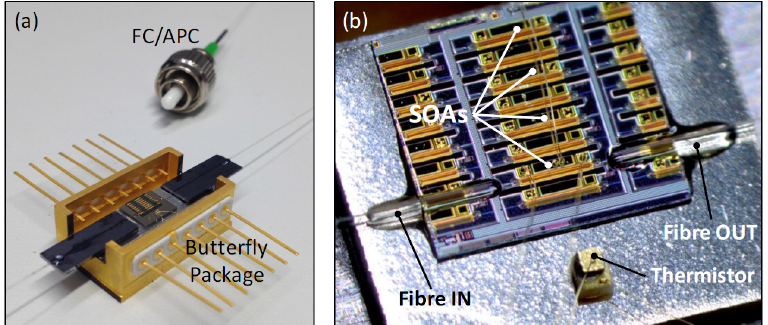
Figure 8. III–V semiconductor optical amplifiers (SOAs) integrated on a Si-PIC; ( a ) Image of a packaged SOA module, with Fiber-to-PIC grating-coupling of the input and output channels in the QPC configuration, to evaluate the optical gain of the SOA; ( b ) Microscope image of the packaged SOA showing the QPC Fiber-to-PIC coupling, and the thermistor used to provide feedback for the integrated thermo-electric cooler (TEC) mounted under the PIC. Table 1. Typical insertion loss, bandwidth, polarization sensitivity, alignment tolerances, and MPW